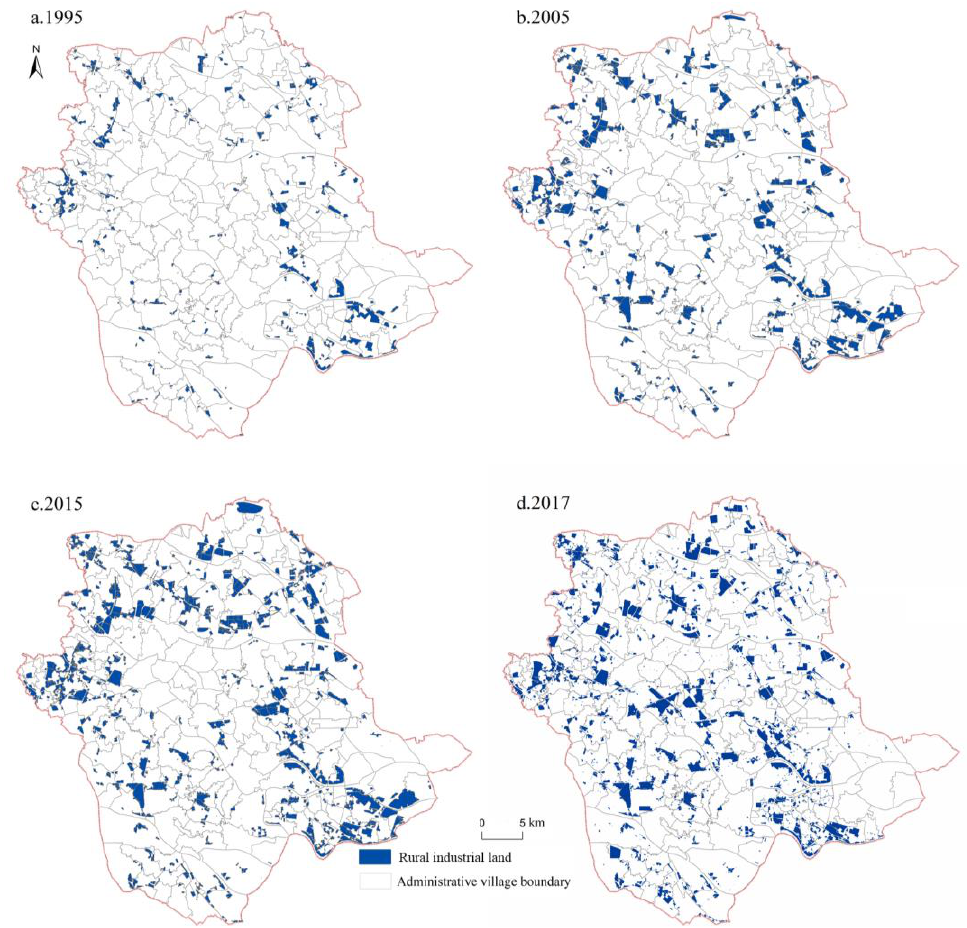
Figure 5. Rural industrial land of Shunde District in 1995 ( a ), 2005 ( b ), 2015 ( c ), 2017 ( d ).